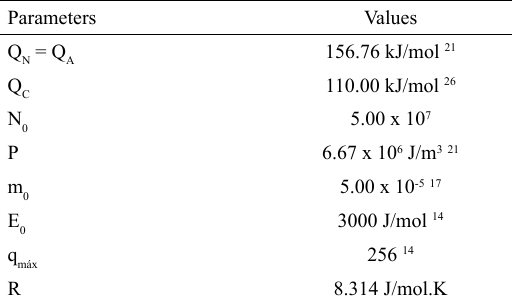
Table 1: Input –parameters for simulation. Parameters